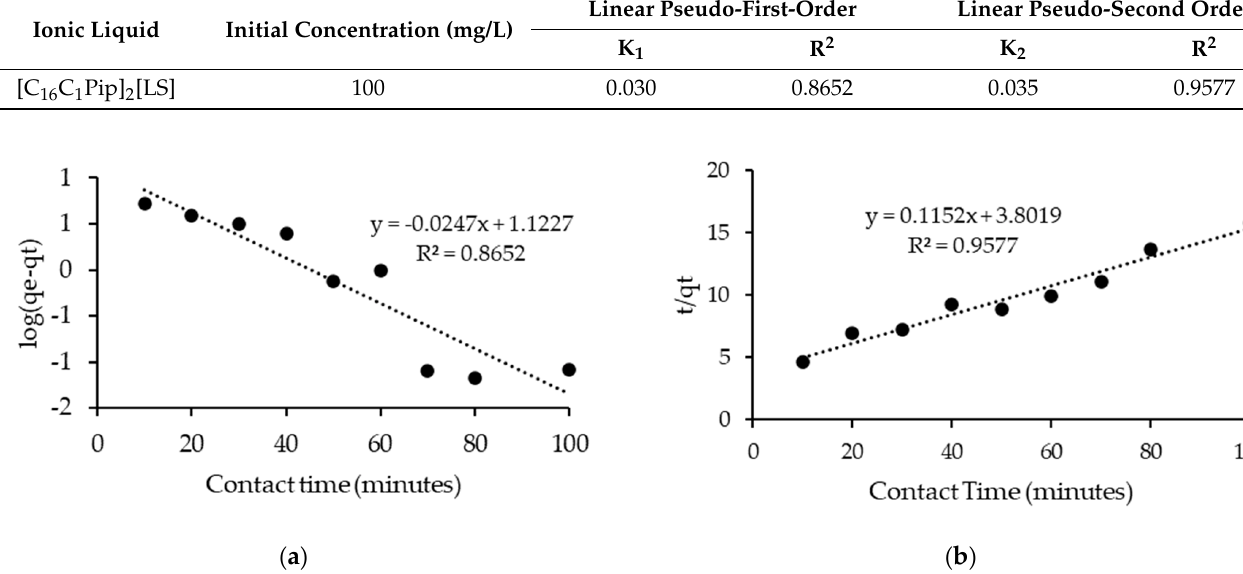
Figure 12. ( a ) Linear pseudo- fi rst order, ( b ) Linear pseudo-second